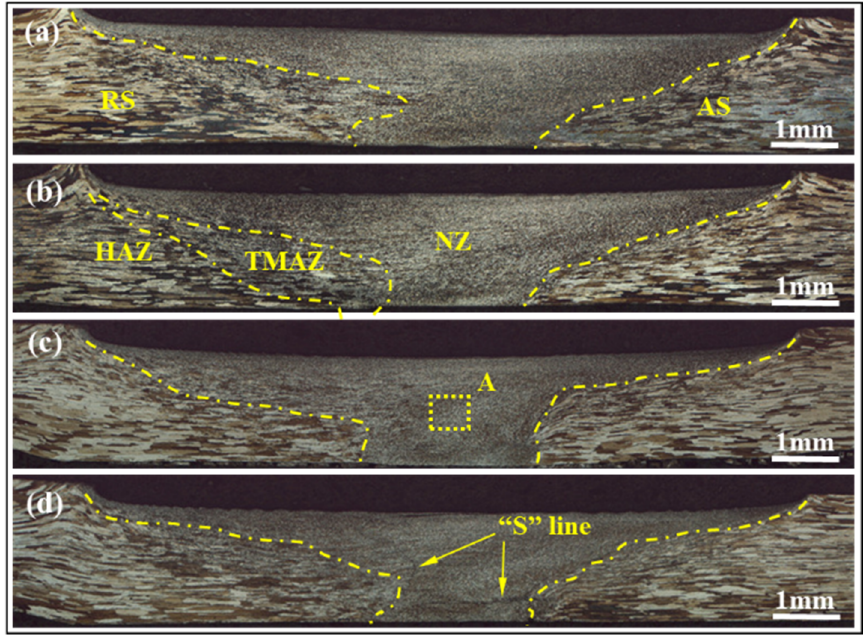
Figure 2. Cross-sections of FSW joints obtained at various welding speeds: ( a ) 90 mm/min; ( b ) 120 mm/min; ( c ) 150 mm/min; ( d ) 180 mm/min.